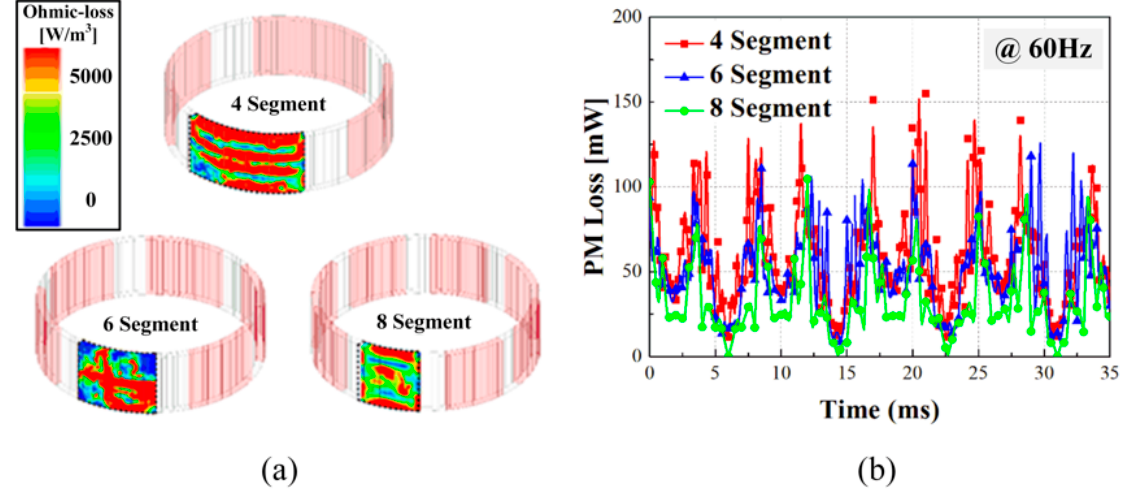
Figure 6. ( a ) Loss comparison according to the number of permanent magnets; ( b ) Eddy current loss comparison according to the number of permanent magnet divisions.